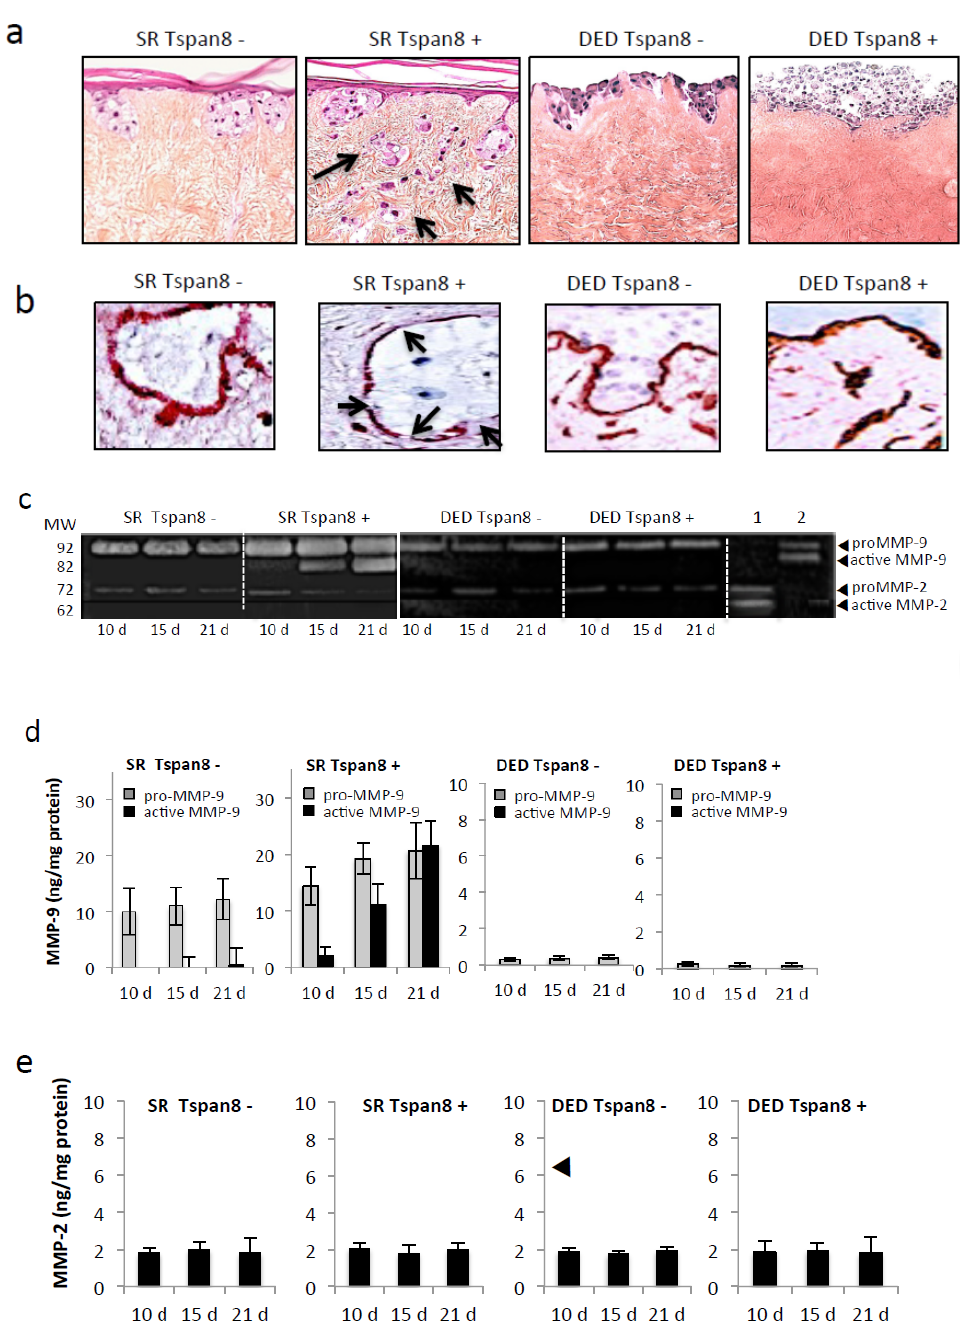
Figure 2. Tspan8-expressing melanoma cells efficiently invade the dermis in human skin reconstructs. Melanoma cells from NM#1 (Tspan8-) and M#1 (Tspan8+) subpopulations were cultured with human keratinocytes (SR) or alone (DED) on acellular dermis. ( a ) Representative photomicrographs of hematoxylin and eosin (H&E)-stained 21-day skin composites (scale bars: 100 μm). Arrows indicate melanoma cells colonizing the dermis ( b ) Representative IHC-staining of collagen IV. Arrows denote collagen IV layer disruptions. ( c ) MMP-9 and MMP-2 activity in gelatin zymography of culture medium from skin composites collected on day 10, 15 and 21. Lane 1, purified MMP-2 standard; lane 2, purified MMP-9 standard both activated with 4-aminophenylmercuric acetate. ( d , e ) ELISA quantification of secreted protein levels of proMMP-9, active MMP-9 (d) and MMP-2 (e) (ng/ug total protein) into the composite media. Bars represent the mean ± SD of three separate experiments with 3 ELISA evaluations for each of the 3 independent experiments ( n = 9).